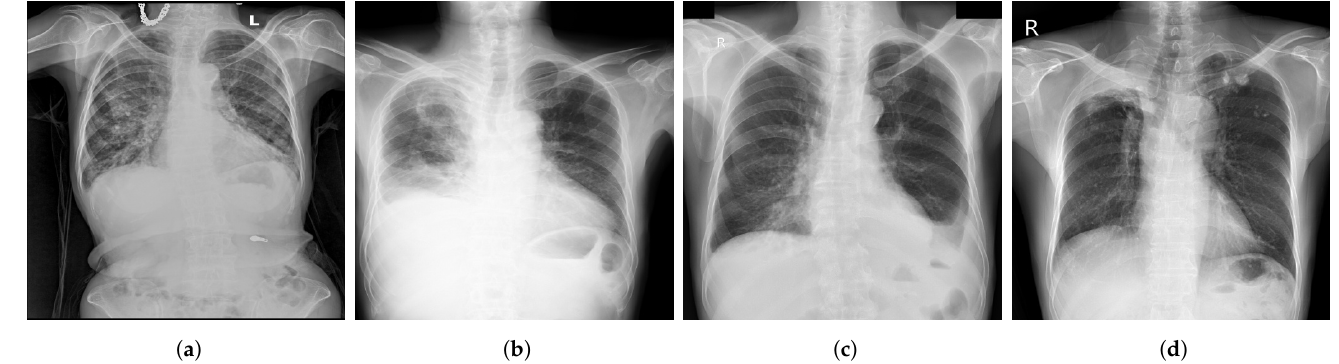
Figure 4. Examples of CXR images from VinDr-CXR dataset [48] where, ( a ) Infiltration; ( b ) Pleural Effusion; ( c ) Pneumothorax; ( d ) Pulmonary